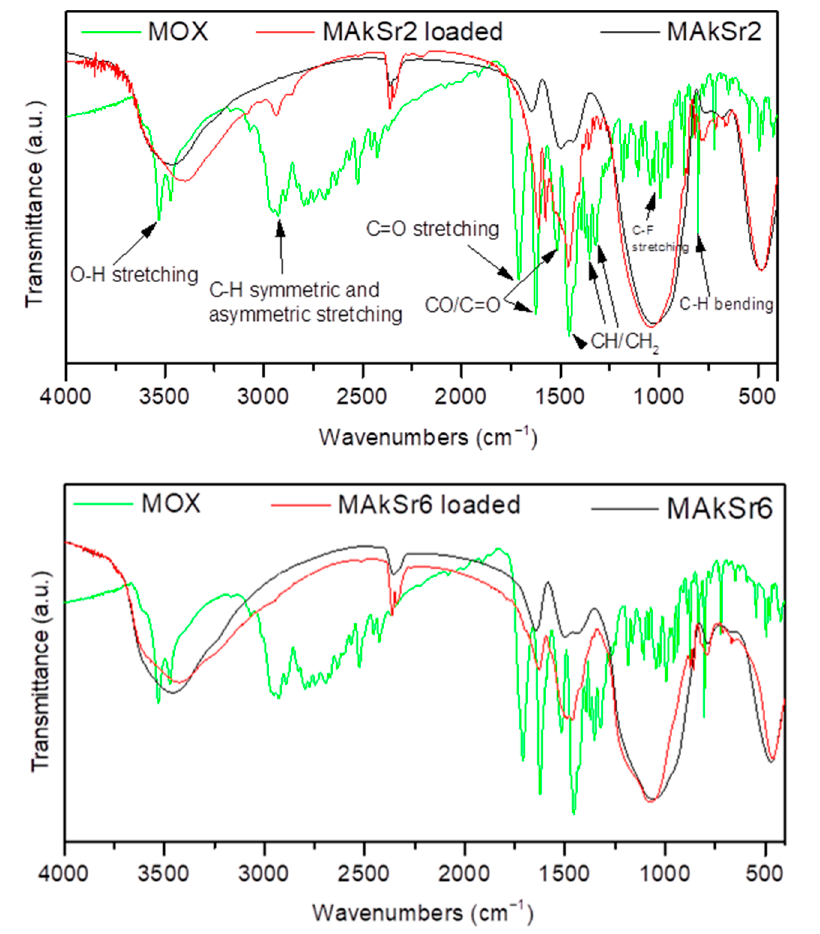
Figure 8. FTIR spectra of MAkSr2 and MAkSr6 before and after loading with moxifloxacin.